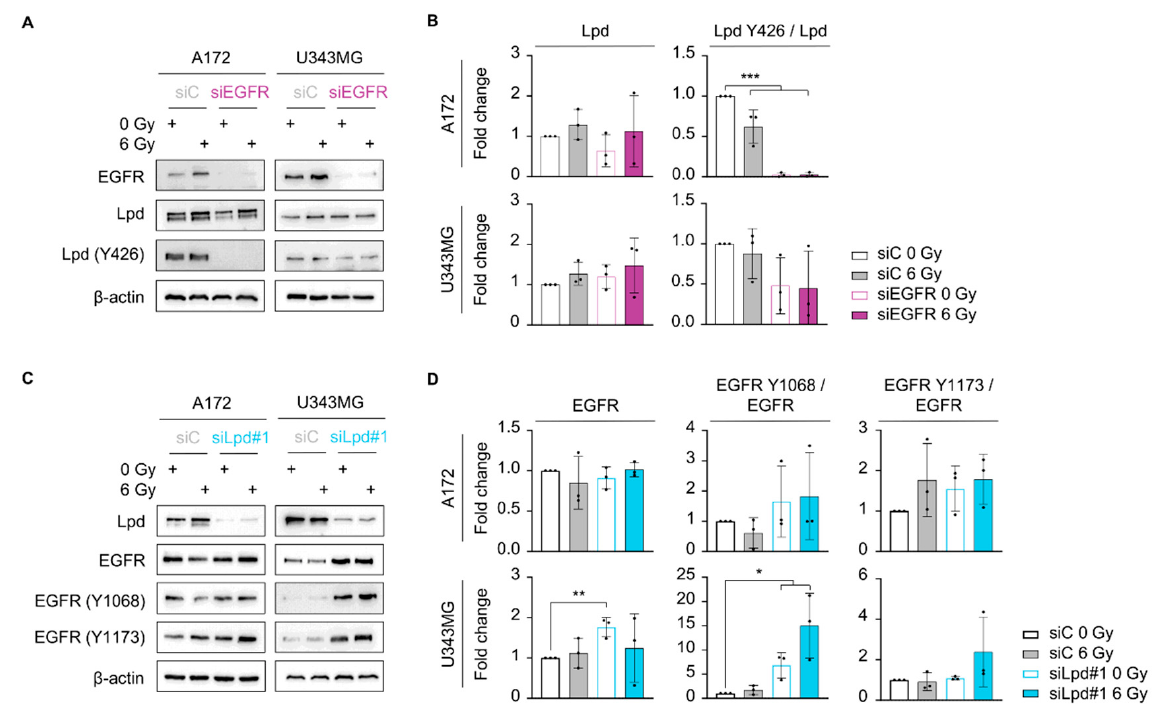
Figure 4. The EGFR-Lpd interplay is cell-line-dependent. ( A ) Representative immunoblot of EGFR, Lpd, phosphorylated Lpd (Y426) and β -actin in A172 and U343MG upon EGFR knockdown and 1 h after irradiation. ( B ) Densitometric analyses showing changes in Lpd expression and phosphorylation from ( A ). Fold changes of Lpd levels are calculated by normalization to β -actin. Fold changes of phosphorylated Lpd Y426 are determined by normalization to total Lpd expression. All protein levels were related to the corresponding β -actin. Fold changes are relative to control-treated and unirradiated samples. ( C ) Representative Western blot from Lpd-silenced A172 and U343MG showing total and phosphorylated EGFR 1 h post-X-ray irradiation. β -actin served as loading control. Representative Western blots are shown. ( D ) Densitometry of EGFR from ( C ). Fold changes of EGFR levels are calculated by normalization to β -actin. Fold changes of phosphorylated EGFR are calculated by normalization to total EGFR expression. All protein levels were related to the corresponding β -actin. Fold changes are relative to control-treated and unirradiated samples. All results are mean ± SD ( n = 3, two-sided Student’s t -test, * p < 0.05, ** p < 0.01, *** p < 0.001). si, small interfering RNA; C, control; Lpd, Lamellipodin.